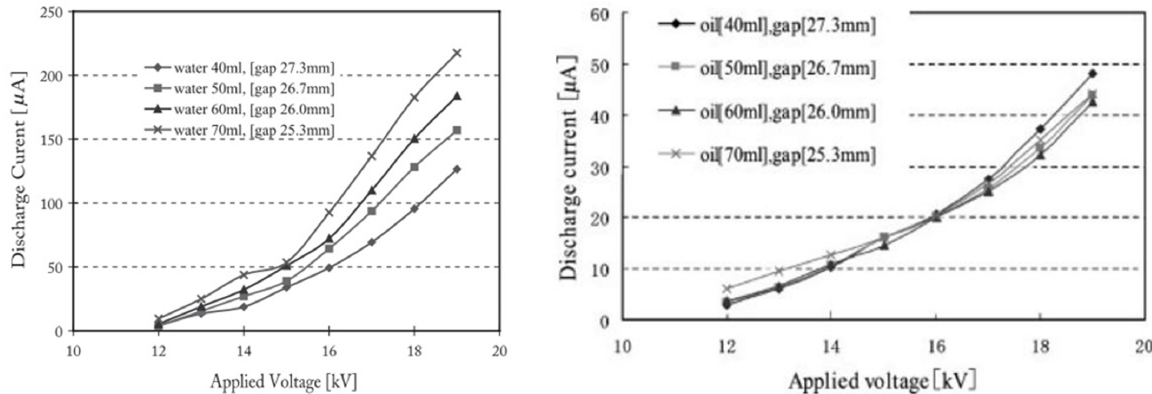
Figure 12. The relation between discharge current of the PM removal device and different air gap from wire electrode to trays electrode ( a ) the trays electrode on water ( b ) the trays electrode on oil. Reprinted from Ref. [93], with permission from John Wiley and